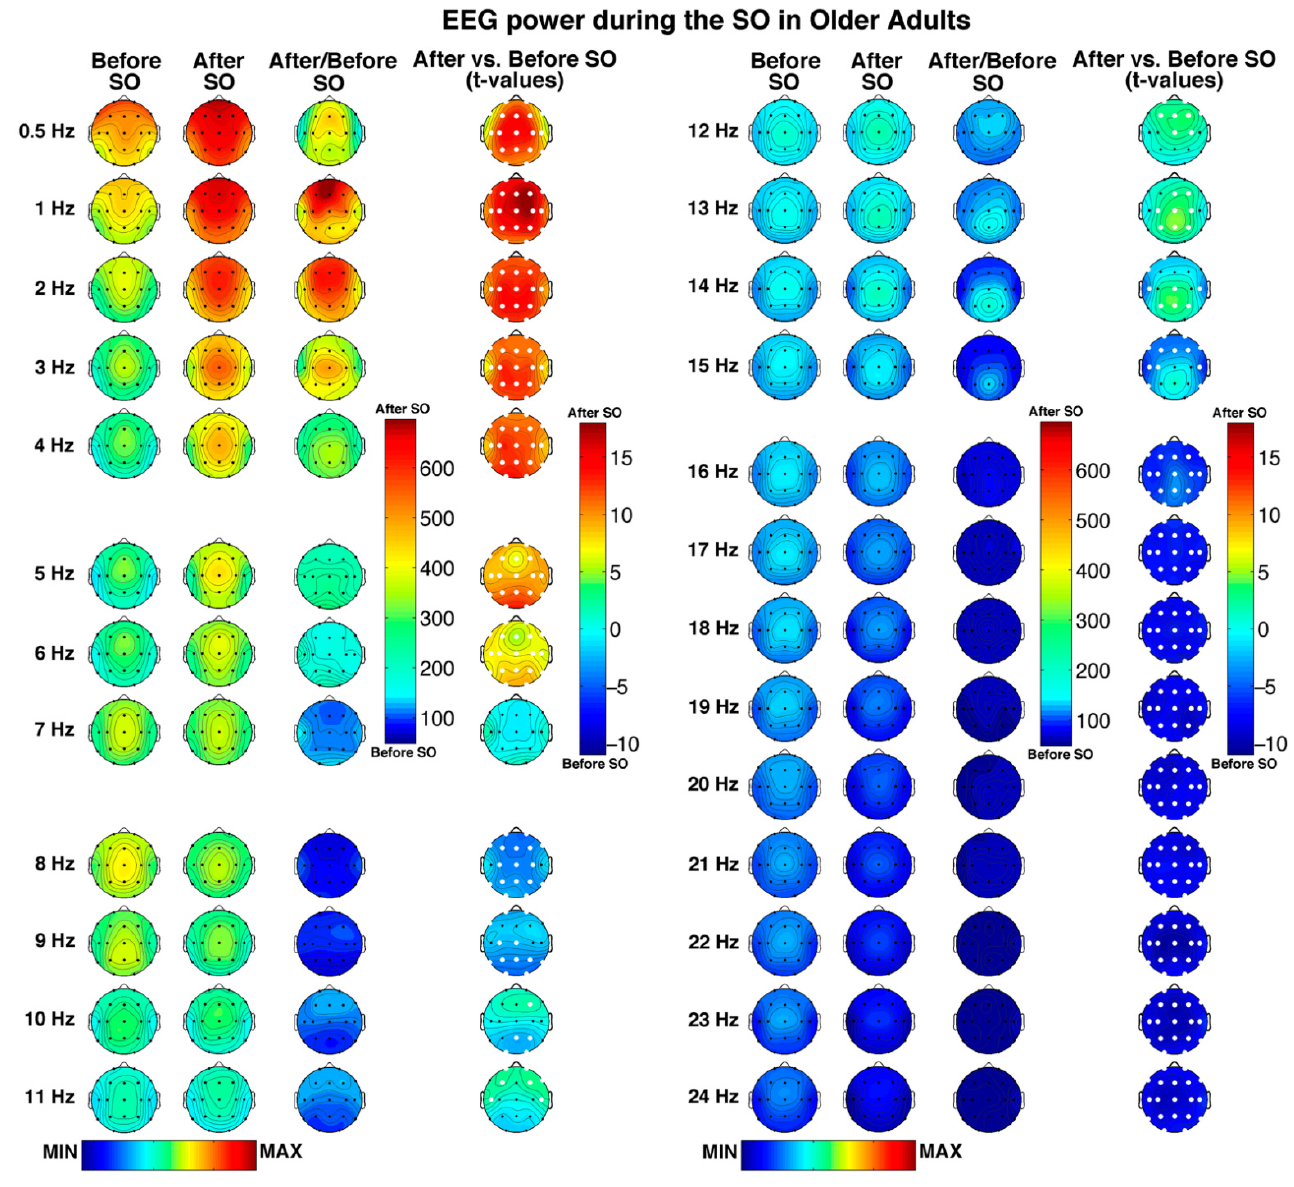
Figure 1. Single Hz electroencephalographic (EEG) topography (left side, frequency range: 0.5–11 Hz; right side, frequency range: 12–24 Hz) during the SO process in older adults. In both halves of the figure, the first two columns depict the topographic distribution of log-transformed absolute EEG power in the 5 min intervals before and after SO, respectively. The maps were scaled between minimal (min) and maximal (max) values calculated for all frequencies and derivations in pre- and post-SO periods. The third column shows the relative EEG changes expressed as the ratio between after and before SO period (Post-SO/Pre-SO × 100). The maps were scaled between min and max values calculated for all frequencies and derivations. The fourth column illustrates the topographical statistical EEG power differences (assessed by paired t -tests) between the post- and pre-SO periods. Values are expressed in t -values: positive t -values indicate a prevalence of the after SO period and vice versa. White dots indicate significant differences after the FDR correction (critic p = 0.037). Values are color-coded and plotted at the corresponding position on the planar projection of the scalp surface and are interpolated (biharmonic spline) between electrodes. The maps are based on the 19 unipolar EEG derivations of the international 10–20 system with averaged mastoid reference, and they are plotted for each frequency Hz bin in the 0.50–24.75 Hz range. A generalized spectral power increase after SO, involving all scalp derivations, can be observed in all frequency bins ≤ 6 Hz. In both pre- and post-SO period, the slowest frequency bins in the delta range showed a clear frontal maximum, becoming